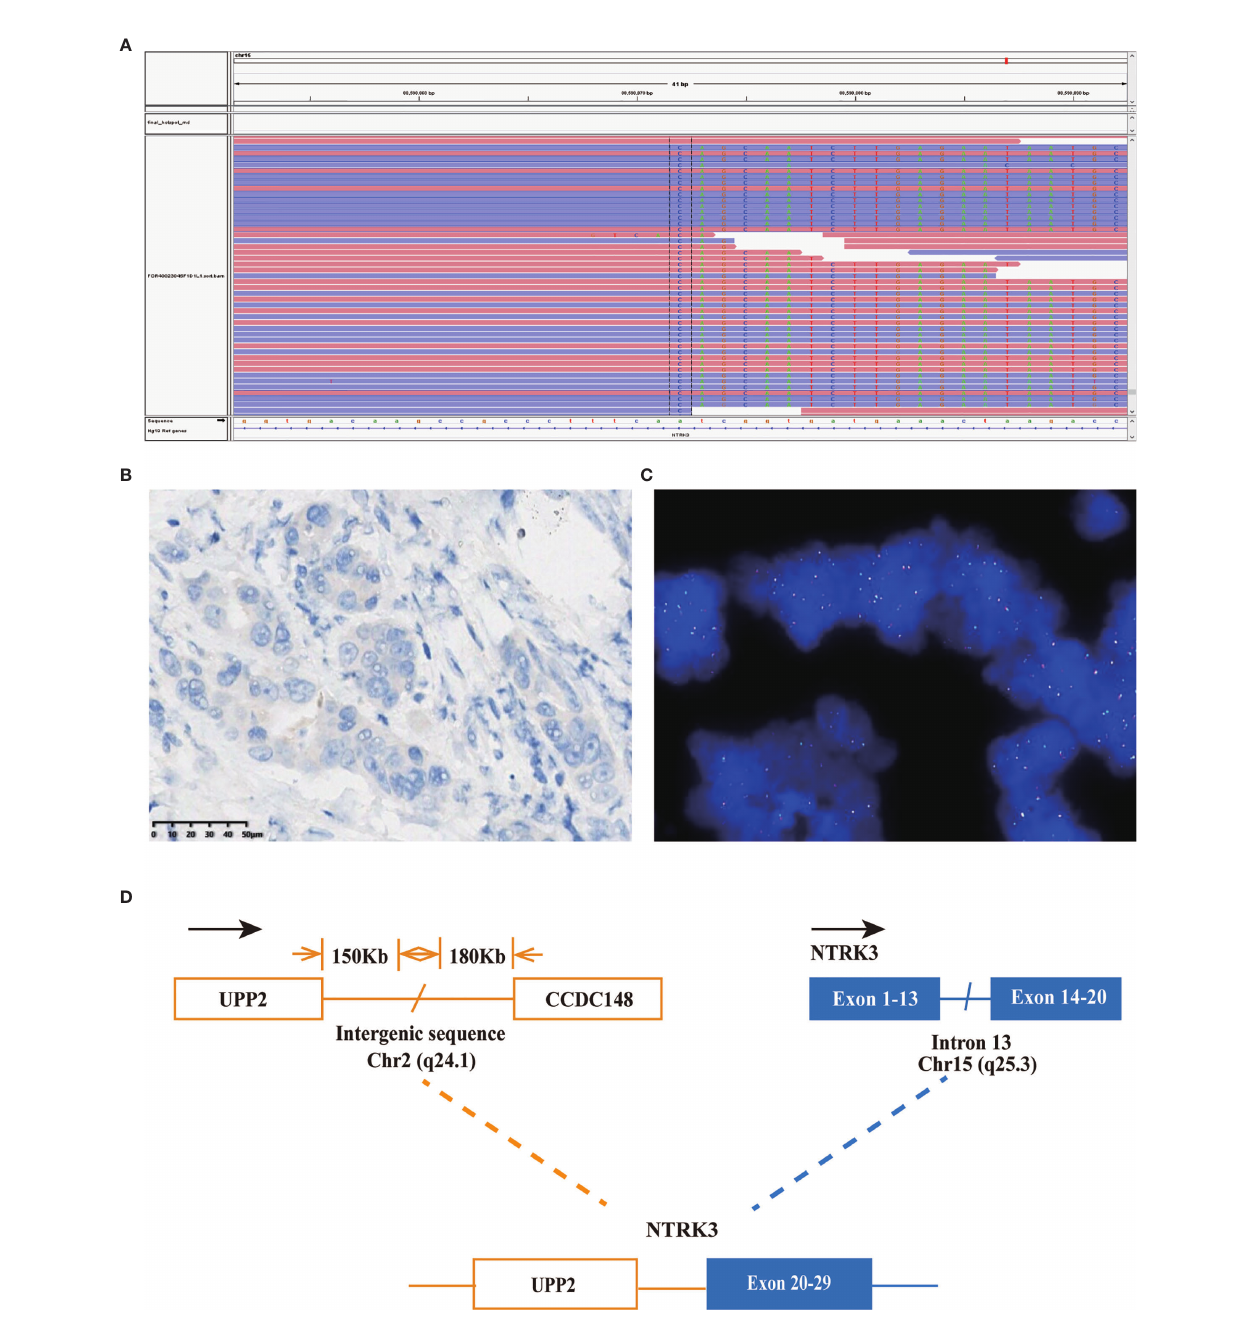
FIGURE 3 | A novel UPP2-NTRK3 intergenic fusion was discovered in a PDCA patient. (A) Sequencing reads of NTRK3 is shown by the integrative genomics viewer. (B) Immunohistochemistry staining indicated expression of NTRK3; the specimen was stained by IHC with the VENTANA pan-TKR (EPR17341) antibody. (C) A split signal was observed with a frequency of 6% in the fl uorescence in situ hybridization image using ZytoLight NTRK3 Break Apart FISH Probe. (D) Illustration of UPP2-NTRK3 intergenic